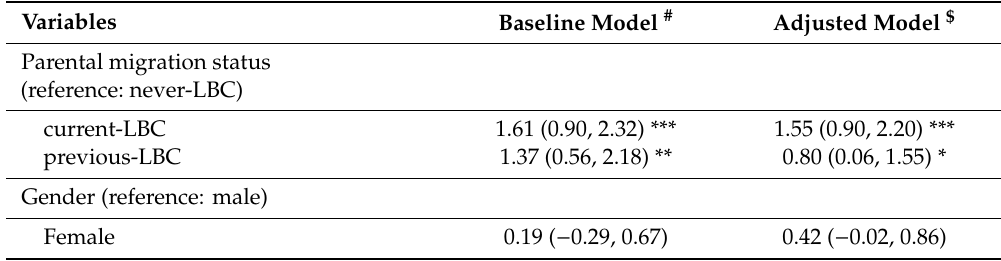
Total difficulties on parental migration status with and without adjustment for parent–adolescent